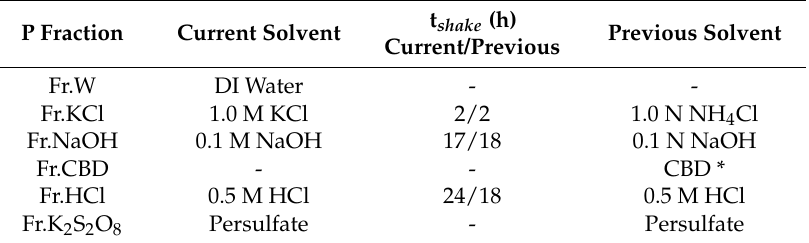
Table 1. Comparison of fractionation schemes used in this and the previous Deer Creek study. The table provides the extracting solution and shaking time for both studies. The first and last P fractions (Fr.W and Fr.K 2 S 2 O 8 ) steps did not include shaking. In the table, “current” refers to this study, “previous” refers to the study by Messer, Hardy and Ihnat